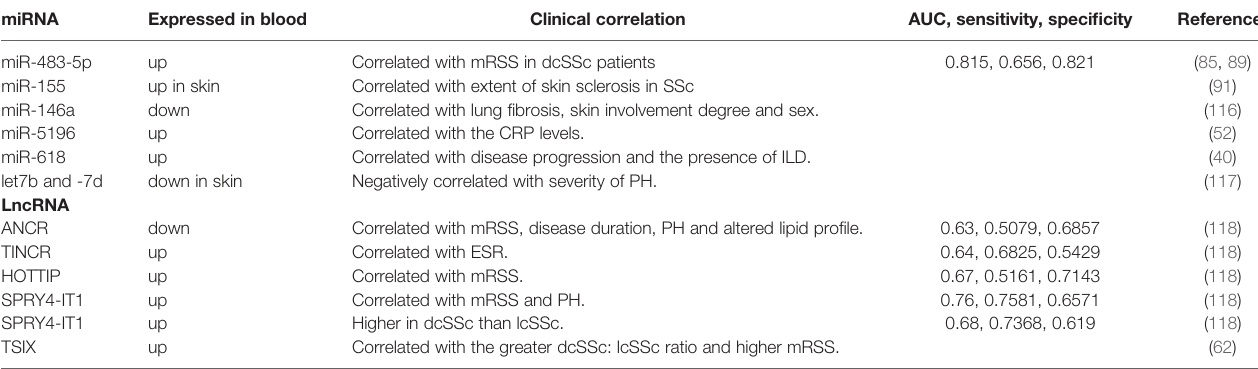
TABLE 3 | ncRNAs as biomarkers in